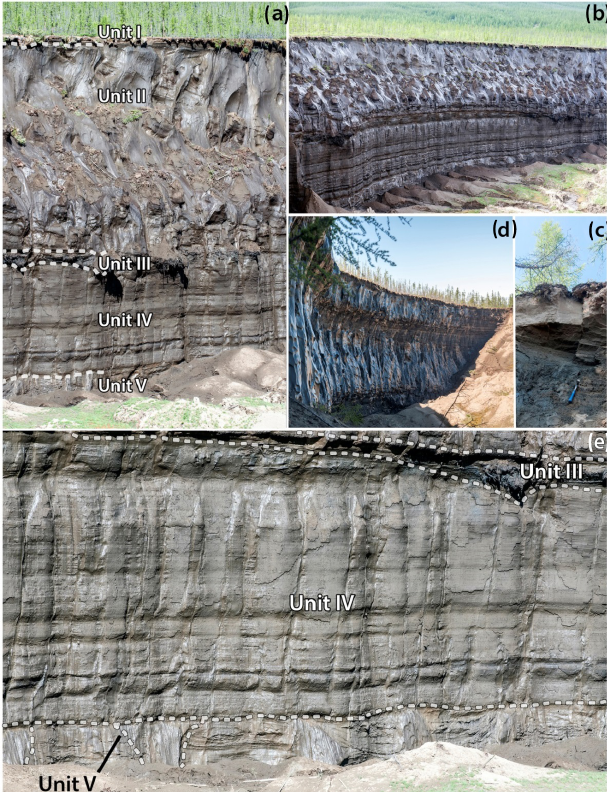
Figure 6. The cryolithological structure of the Batagay exposure in its western and southwestern part. (a) General position of the detected cryolithological units (I to V). (b) Overall view of the out- crop. (c) Unit I (140cm thick active layer) and boundary to Unit II (YIC) in section A. (d) Unit II, steep wall of the YIC illustrating the three observed subunits differing in ice content and contour. The trees as scale on top of the wall are about 6–8m tall. Section A is situated at the upper part of the slope, on the right side of the photo. (e) Detail of the three lower cryolithological Units III, IV, and V. The old ice complex Unit V with preserved syngenetic ice wedges is only partly